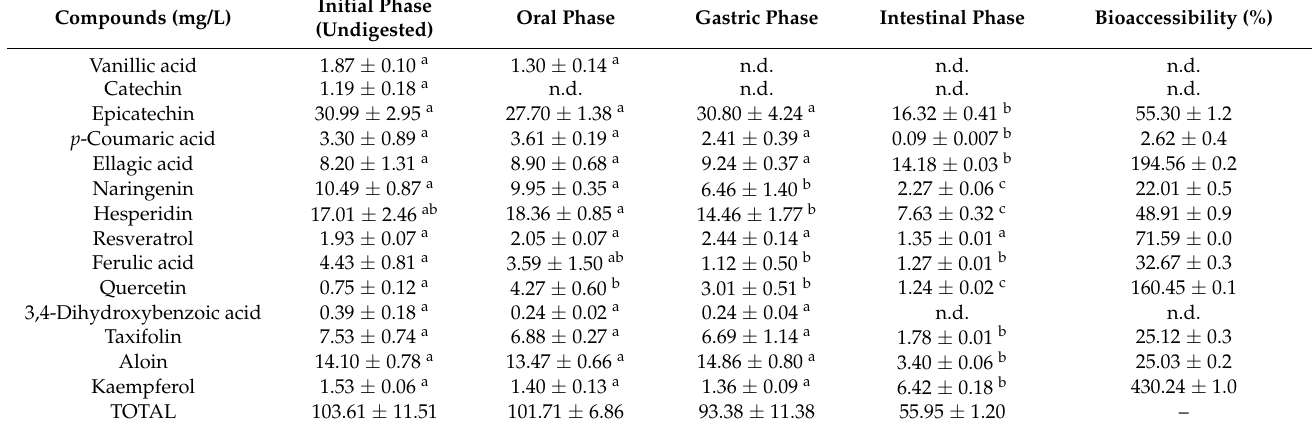
Table 2. Phenolic compound identification and quantification of undigested and in vitro digestion of non-fermented Aloe vera juice ( Av ). Data are given in